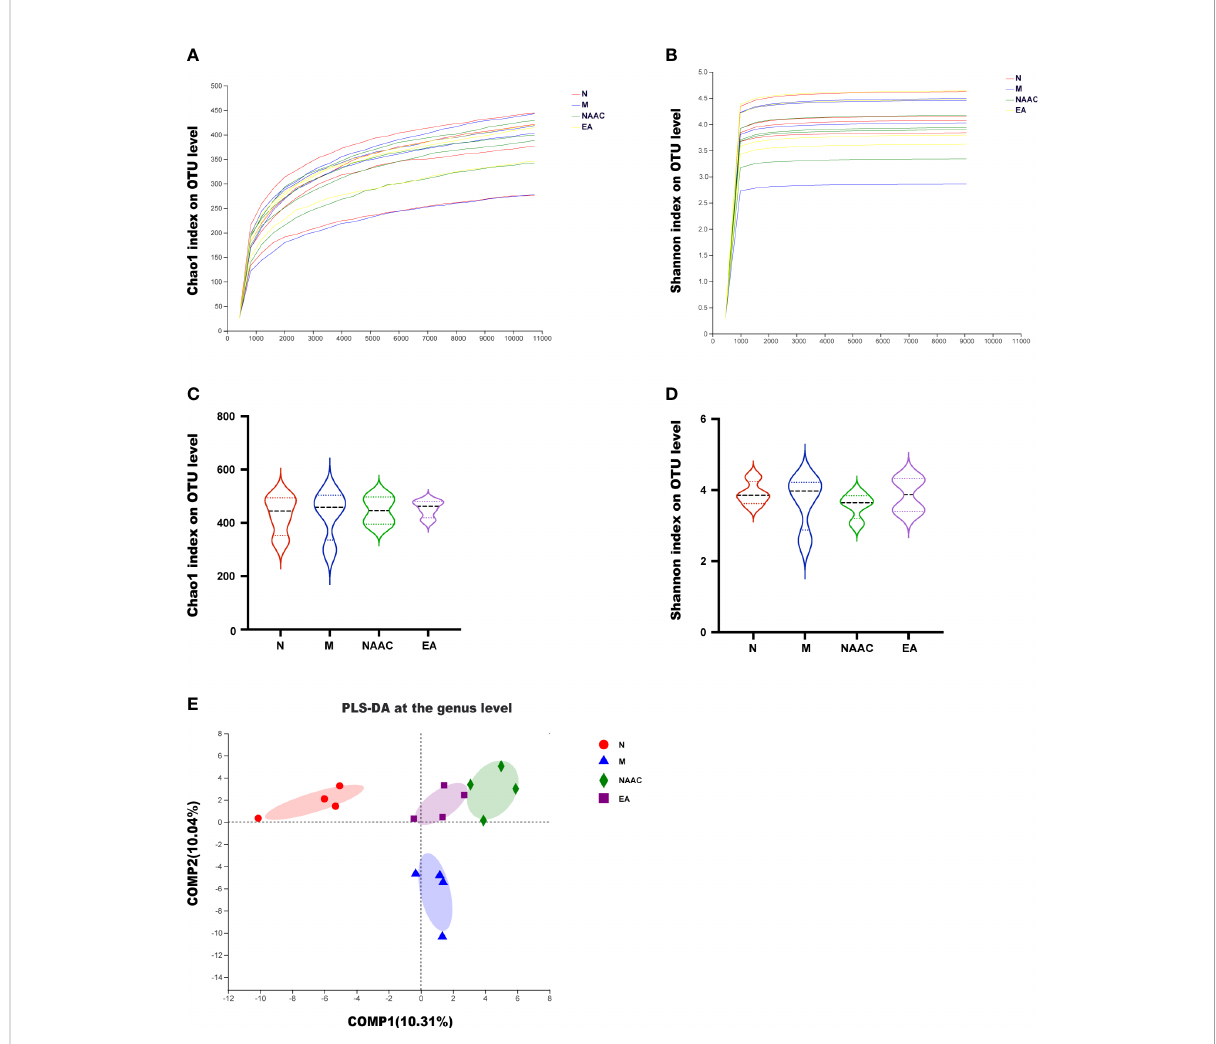
FIGURE 2 Diversity of the microbial community associated with the rats in each group. Alpha rarefaction curve (A, B) and violin plot analysis (C, D) . The alpha index rarefaction curves show the differences in species abundance among samples and evaluate the rationality of the sequencing quantity of samples. Violin plot analysis of alpha diversity using the Kruskal – Wallis test re fl ected the dispersion degree of samples in the group and the intergroup index differences. The Chao1 index (A, C) re fl ected richness, and the Shannon (B, D) index considered diversity. (E) Beta diversity (PLS-DA) of the four groups, showing the similarities and differences in species composition among different individuals or groups. The results demonstrated that there were differences in the composition of the four